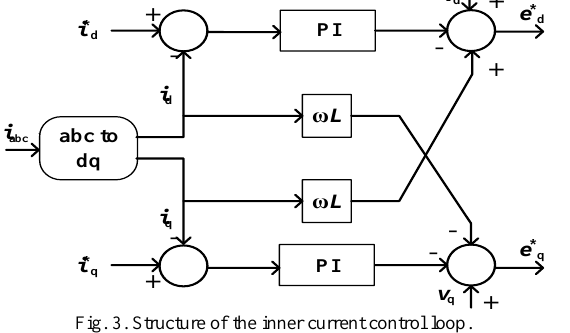
Fig. 3. Structure of the inner current control loop.